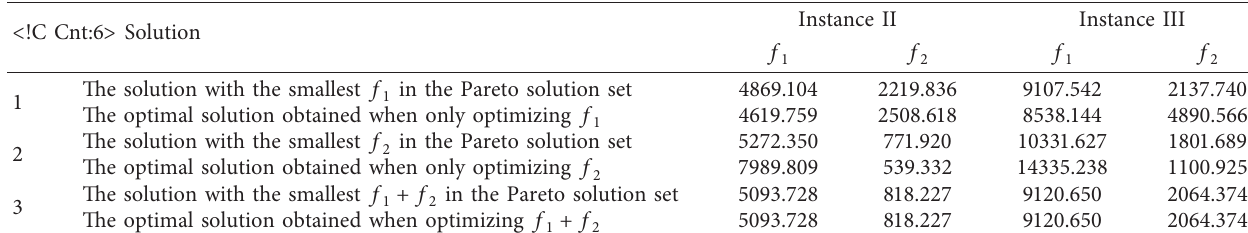
Table 6: Comparison of single-objective optimization and Pareto solution set for Instance II and Instance